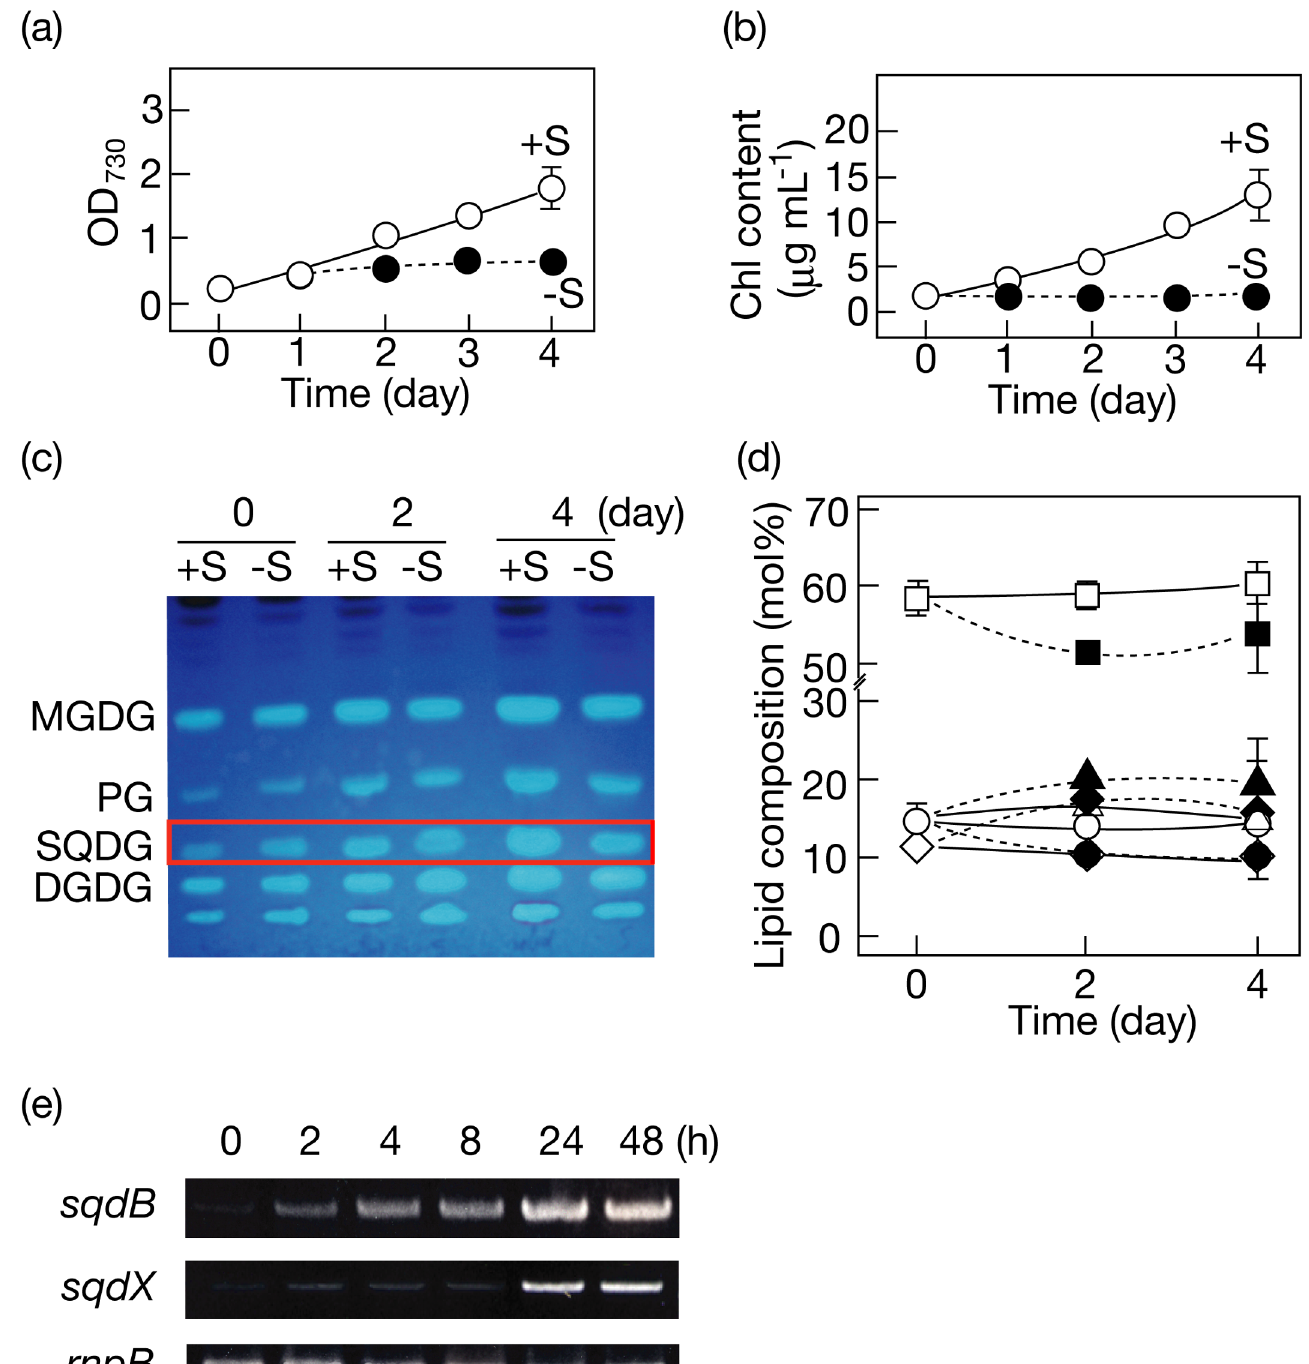
Fig 4. Effects of S-starvation on cell growth, Chl and polar lipid contents, and sqdB / sqdX genes in Synechococcus . OD 730 (a) and the Chl a content (b) were determinedfor a culture of cells under +S (open circles) or–S (closedcircles) conditions. (c) Changesin the TLC profiles of polar lipids are shown for a culture of cells under +S or–S conditions. The solvent system was the same as that in Fig 3C. (d) Changesin the polar lipid compositionsare shown for cells grown under +S (open circles) or–S (closed circles) conditions. The symbols for lipids are the same as those in Fig 3D. (e) Expression of sqdB , sqdX , and sqdBX operonwas examinedin the WT under +S or–S conditionsthrough RT-PCR. Expression of the rnpB gene for a subunitof ribonucleaseP was investigatedas an internalcontrol. The values shownare the averages ± SD for three distinct groupsof data.